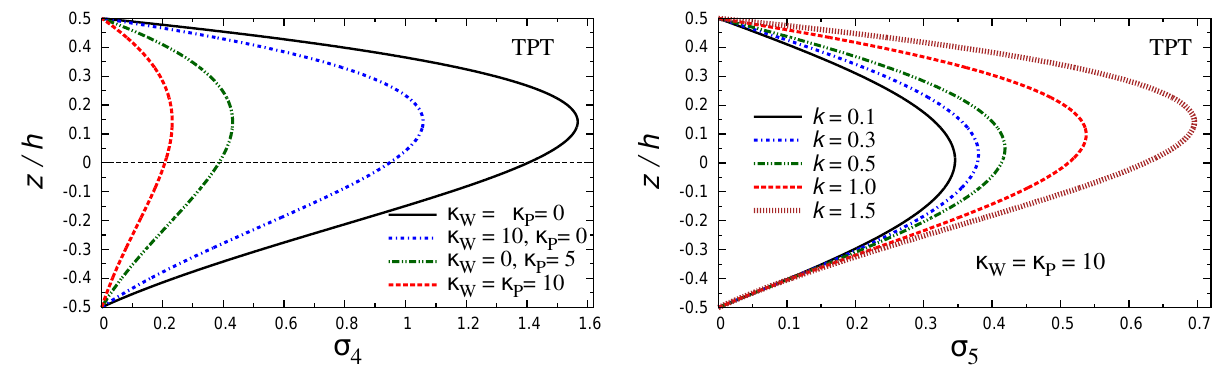
Figure 11: Through-the-thickness distributions of transverse shear stress σ 5 of the EG thick rectangular plate resting on Pasternak parameters ( a = 4 h , b = 3 a )